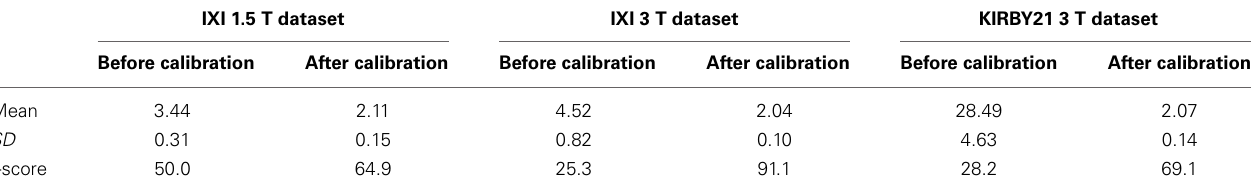
Table 3 | T1-w/T2-w reliability